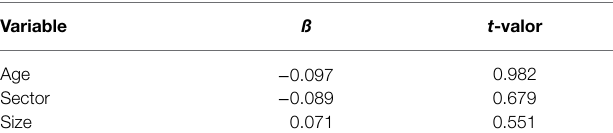
TABLE 8 | Control variables.